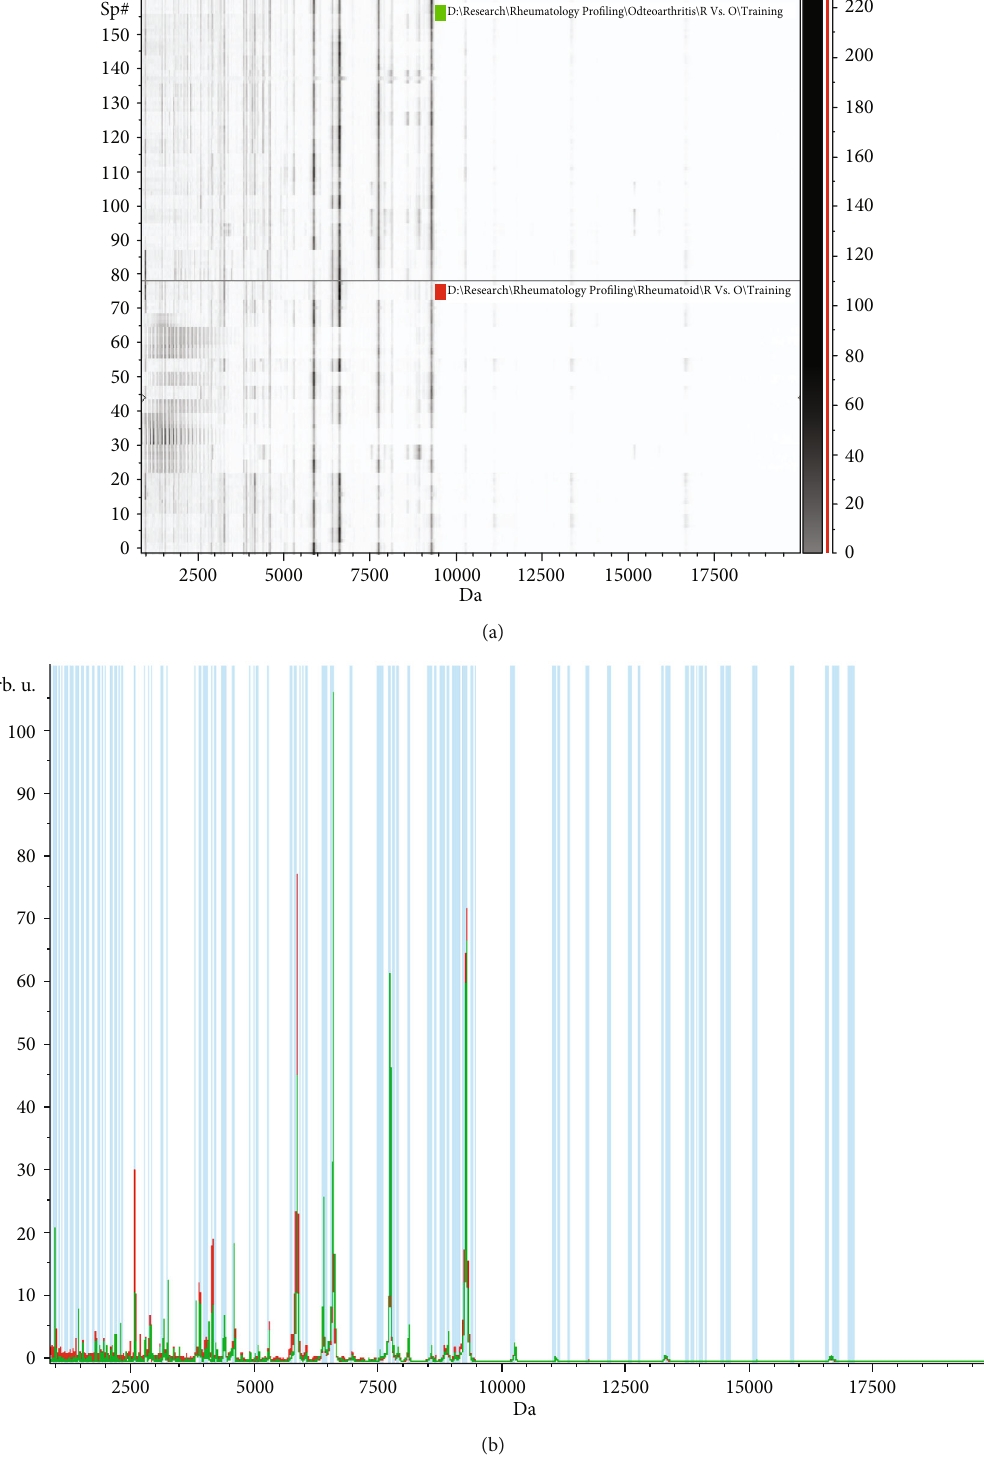
Figure 1: Peptidomic analysis of rheumatoid arthritis (RA) versus osteoarthritis (OA) group. (a) The pseudogel view using ClinPro Tools. The RA group at the bottom and OA group at the top. Each peak is represented by a vertical line. The di ff erence in intensity between the lines represents the di ff erential peak expression between the two groups. (b) The whole spectral view in ClinPro Tools. The fi gure represents the RA group in red against the OA group in green. Peaks included are demarcated with vertical blue lines. Peaks demarcated with red vertical lines are the integration